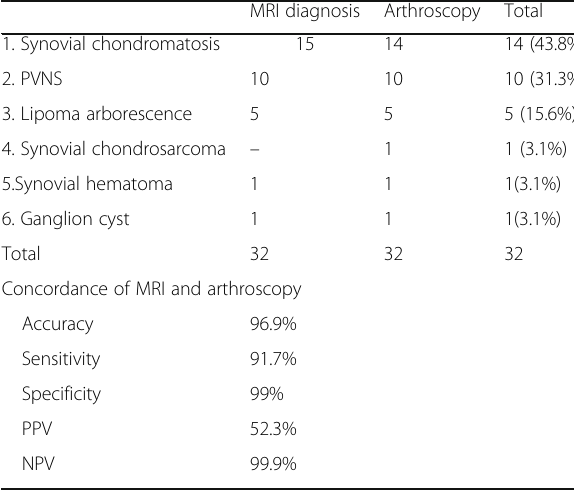
Table 2 MRI diagnosis of the synovial lesions compared